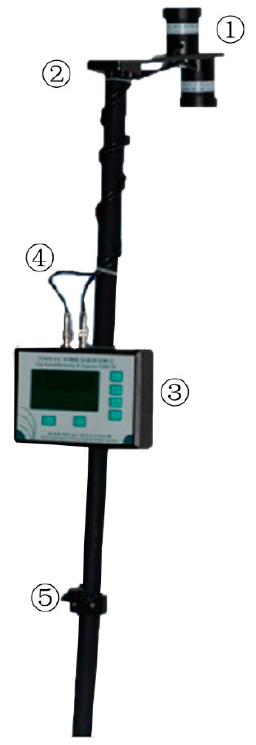
Figure 1. Portable three-band instrument of crop-growth monitoring and diagnosis ：① Multi-spectral crop sensor; ② Sensor support; ③ Processor system; ④ Shielded cable; ⑤ Level.